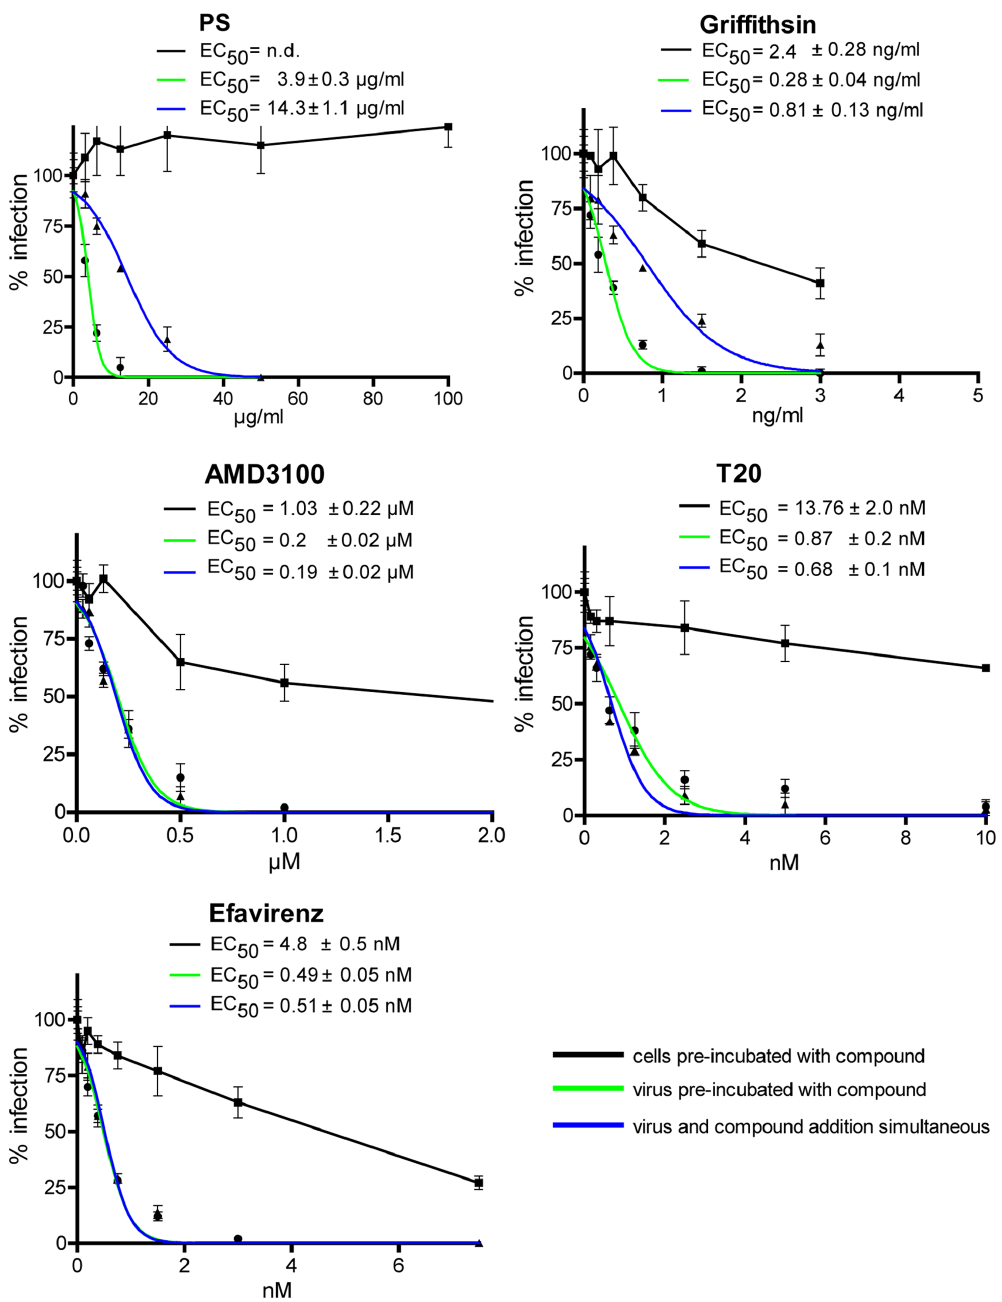
Figure 3. Effects of pre-incubation of virus preparations or target cells with PS extracts or reference compounds on inhibition of HIV-1 infection. Inhibition of HIV-1 infection by PS extract was enhanced by pre-incubation of virus preparations with PS extract, compared to inhibition of infection without virus pre-incubation. HIV-1 target cells pre-incubated with PS extract prior to infection did not retain HIV-1 inhibitory activity. Virus pre-incubation (green curves): Inhibitory activity of PS extract was assayed with HIV-1 LAI virus preparations pre-incubated with different concentrations of PS extract for 4 hours before adding to LC5-RIC cells. Target cell pre-incubation (black curves): LC5-RIC cells were incubated with different concentrations of inhibitors and subsequently exposed to HIV-1 LAI in fresh medium in the absence of inhibitors. No pre-incubation (blue curves): Virus and inhibitors were added simultaneously to LC5-RIC cells. The entry inhibitors Griffithsin, AMD3100 and T20 and the reverse transcriptase inhibitor Efavirenz were analyzed as reference compounds. Mean values of triplicate wells and standard deviation of the mean are indicated for each extract concentration.